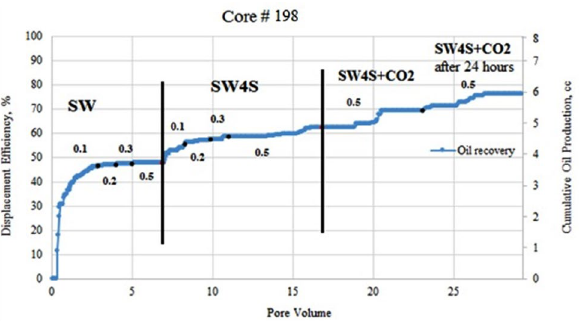
Fig. 11 Coreflood recovery results on secondary, tertiary and quater- nary modes (Kilybay et al.